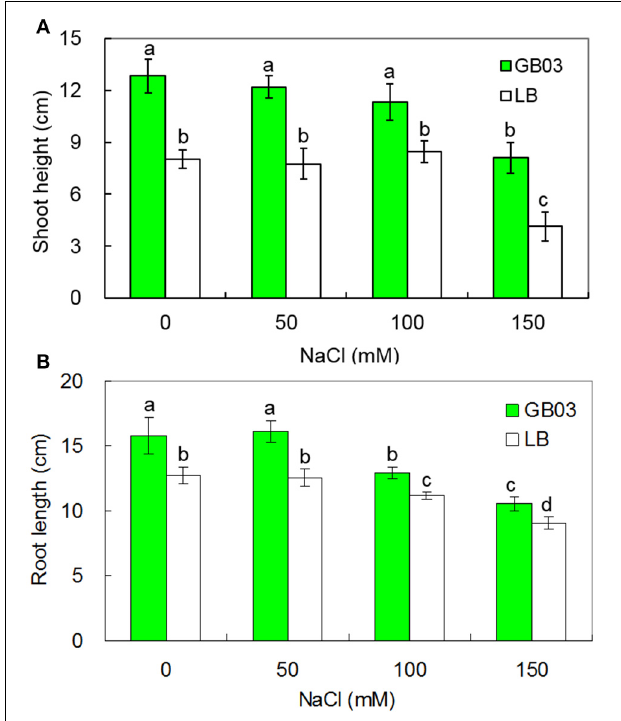
FIGURE 1 | Effects of GB03 bacterization on shoot height (A) and root length (B) of white clover under various concentrations of NaCl. Values are means and bars indicate SDs ( n = 8). Columns with different letters indicate significant difference at P < 0 . 05 (Duncan